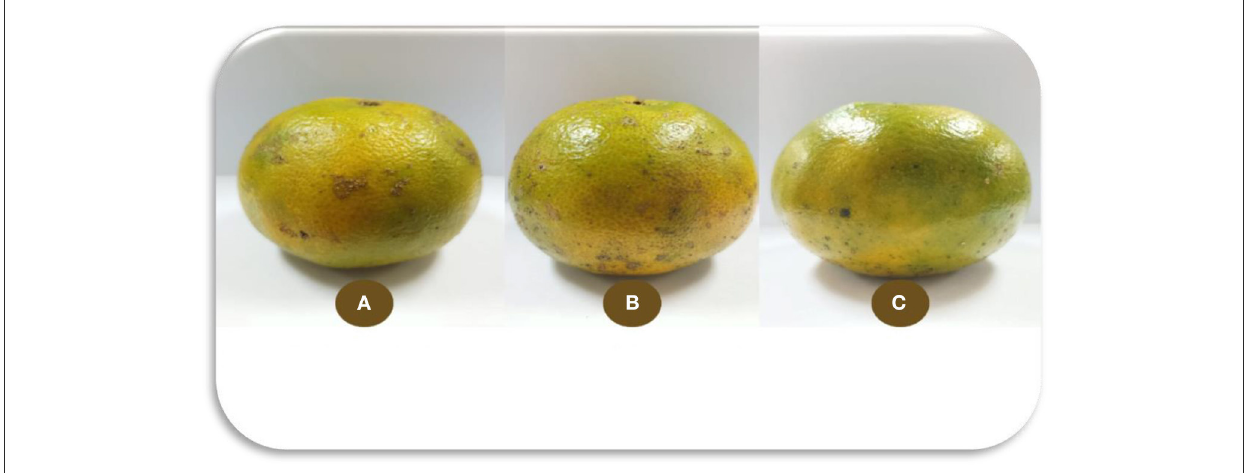
FIGURE9 Siamese orange. (A) Siamese oranges without coating. (B) Siamese oranges with coating application. (C) Siamese oranges with nanocoating